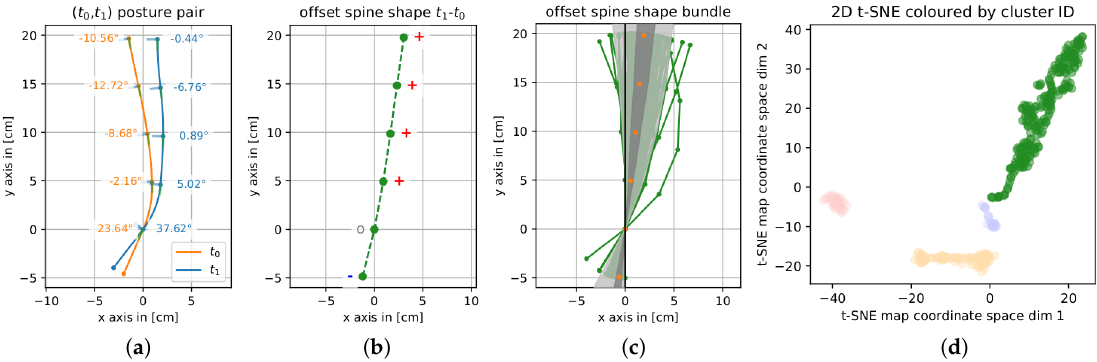
Figure 3. ( a ) Two spine shapes reconstructed from the t 0 and t 1 input angles and ( b ) resulting offset spine shape . ( c ) Offset spine shape bundle representing a data cluster in the feature set’s T-stochastic neighbor embedding (t-SNE) map ( d ), colored by cluster